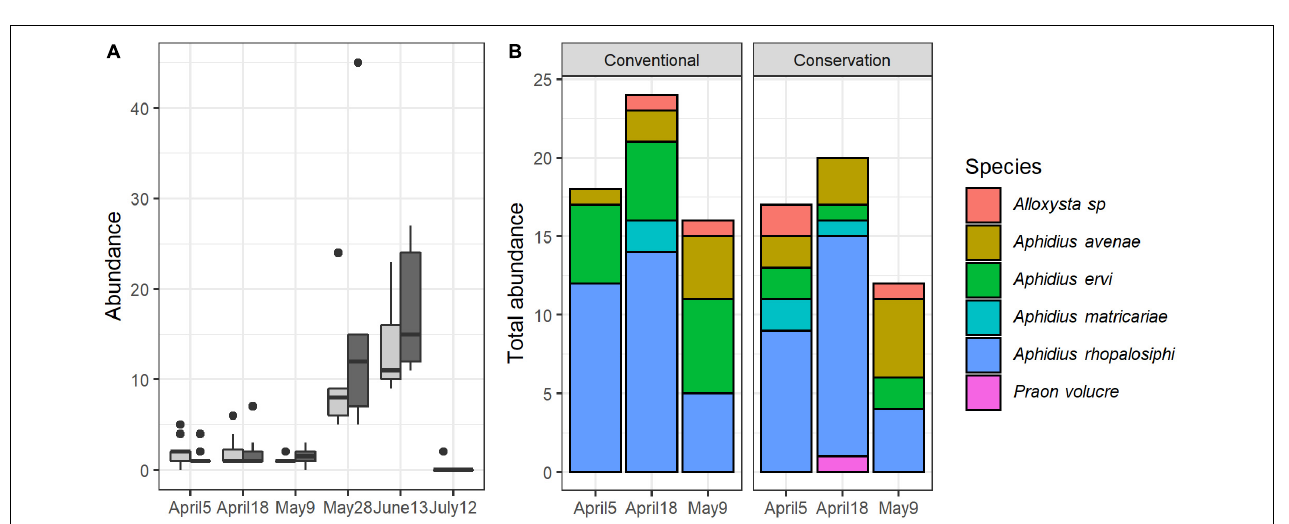
FIGURE 5 | Variations over time and soil management of cumulative abundance of carabid species in the emerging community representing at least 80% of the total abundance. Indicator species are bolded.